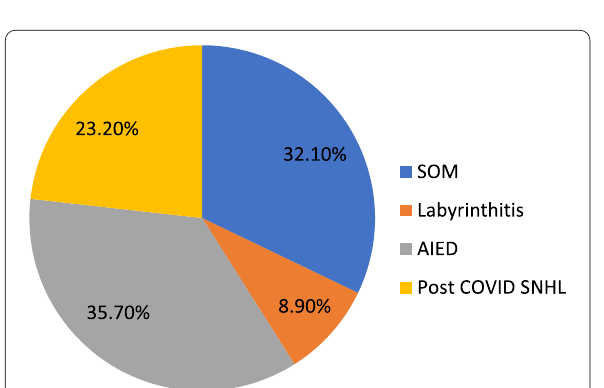
Fig. 3 Audiological diagnosis according to history and audiological findings.